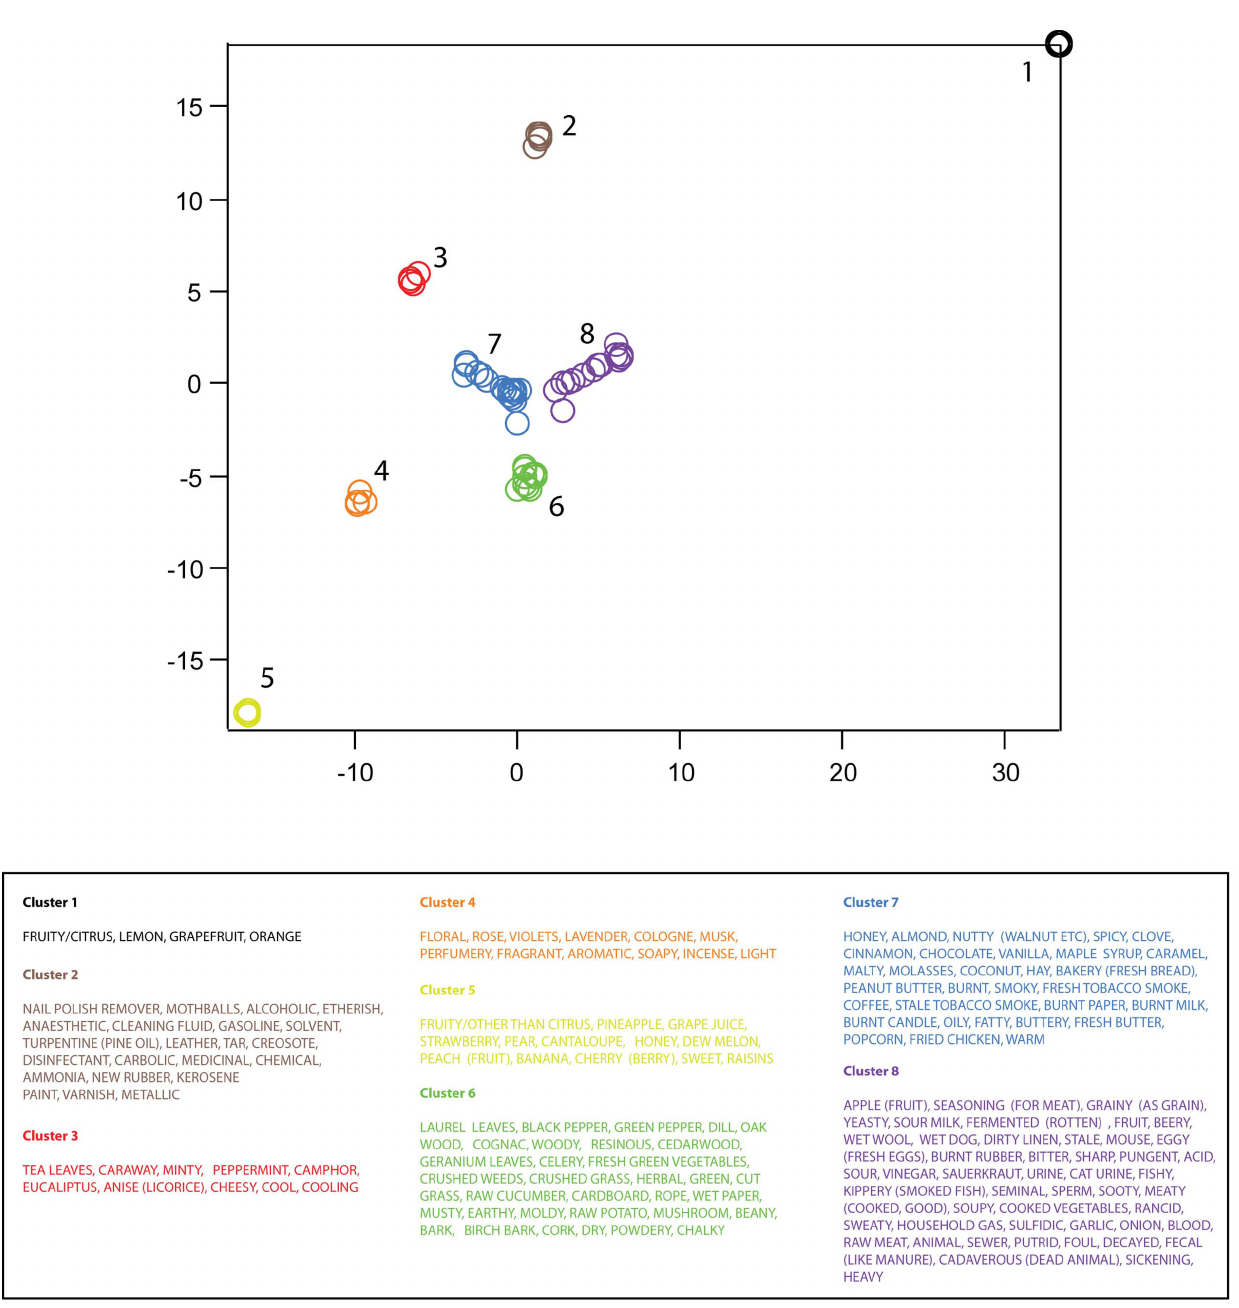
Figure 7. Two-dimensional embedding of the descriptor-space, W . Results of stochastic neighbor embedding (see text) applied to the similarity matrix for W . Axis units are arbitrary, but preserve neighbor relations present in the higher dimensional space, W . Note that discrete clusters are clearly evident. Clusters were identified by eye, and descriptors composing each cluster are listed in the table below.